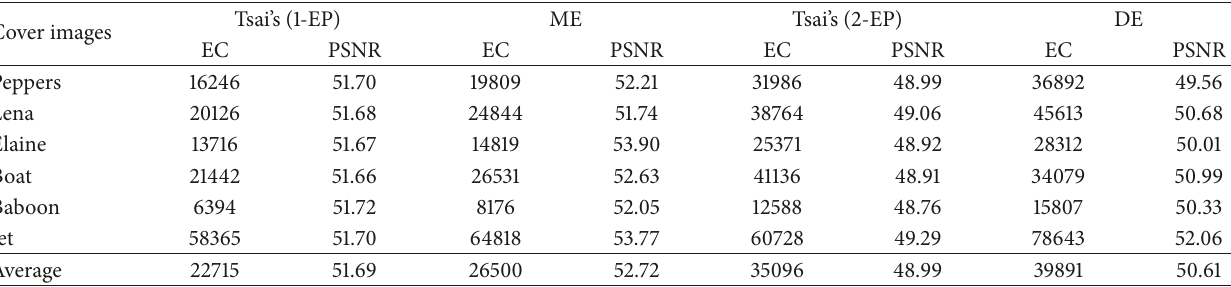
Table 3: Analysis of the restored and embedded effect of double, complementary